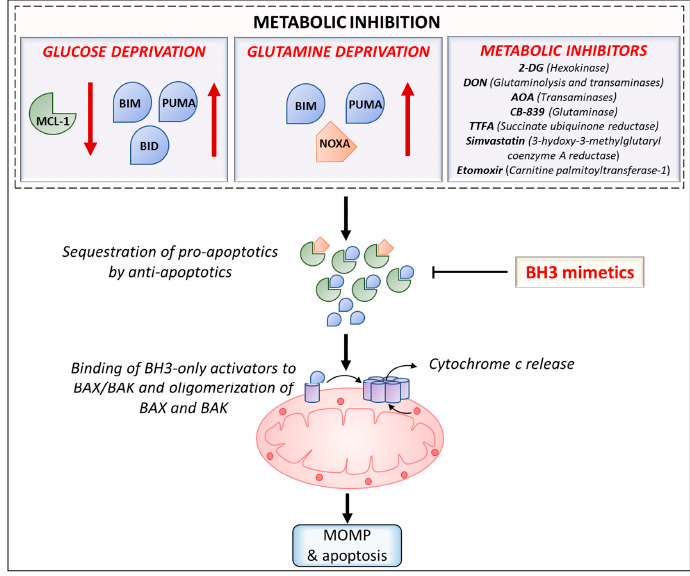
Figure 2. Metabolic regulation of BCL-2 proteins inducing sensitization to BCL-2 antagonists. Glucose/glutamine deprivation can modulate the levels of BCL-2 proteins resulting in changes in binding of BH3-only proteins with the anti-apoptotic proteins. Treatment with BH3-mimetics can release activators from anti-apoptotics. Unbound/released activators then activate BAX/BAK and initiate MOMP. A subset of metabolic inhibitors (pre-clinical leads and small molecules in clinical trials) that elevate the primed state and increase sensitivity to BCL-2-targeted BH3 mimetics have been shown along with their targets. Abbreviations: 2-DG: 2-deoxyglucose; DON: 6-diazo-5-oxo-L-norleucine; AOA: aminooxyacetic acid; TTFA: thenoyl